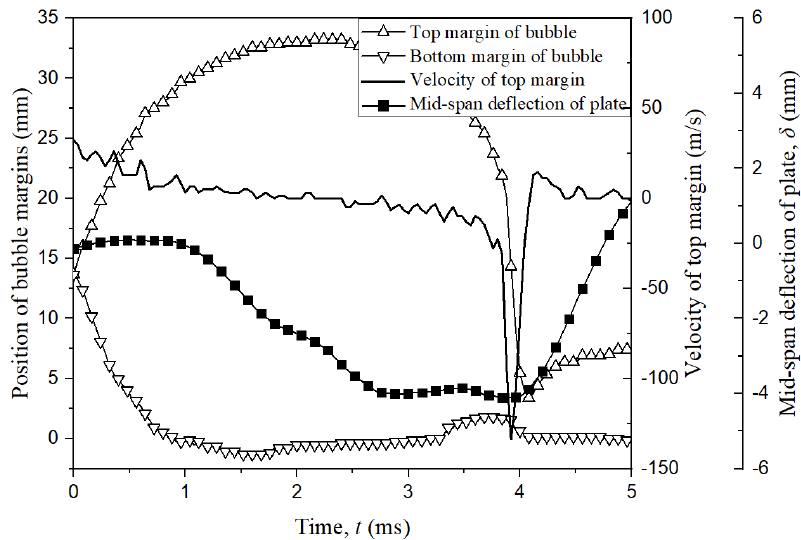
Figure 5. The comparison of the temporal evolution of two bubble margins, velocity of top margin, and mid-span displacement of elastic boundary for γ = 0.81 and R m = 19.4 mm.